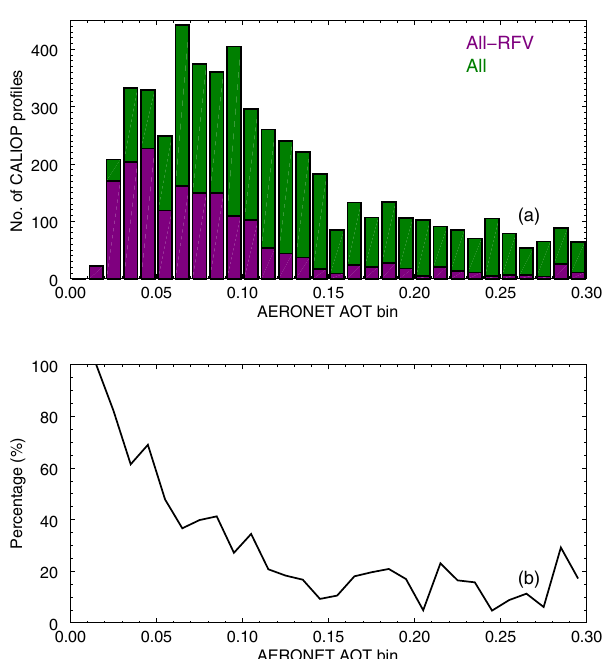
Figure 8. For the 2007–2008 and 2010–2011 periods: (a) his- tograms of all cloud-free CALIOP profiles (in green) and all- RFV profiles (in purple), and (b) corresponding frequency of oc- currence (%) of cloud-free CALIOP all-RFV profiles, relative to all cloud-free CALIOP profiles, both as a function of collocated coastal/island AERONET AOT (0.01